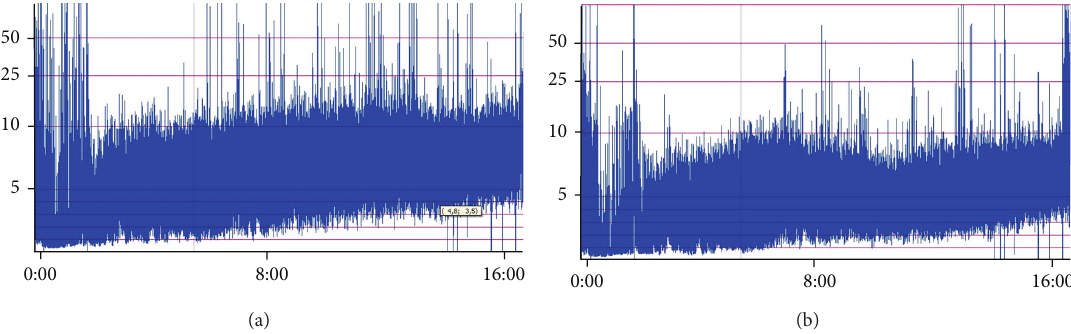
Figure 1: Cerebral function monitoring (CFM) of an infant newborn with an apparent life-threatening event following maternal temazepam use during labour. On 𝑥 -axis time (in hours) since admission on neonatal intensive care unit. On 𝑦 -axis cerebral function of right (b) and left side of the brain expressed in microvoltage ( 𝜇 V). Initially CFM monitoring showed burst suppression and changed to continuous low voltage in 2-hour time. Later on, CFM pattern returned to a discontinuous normal